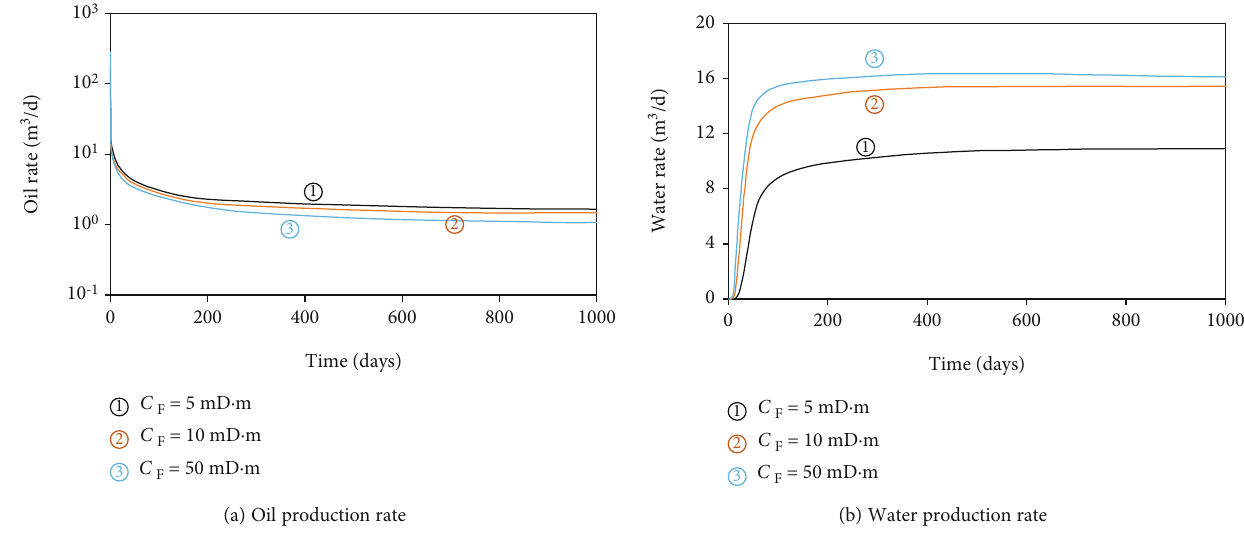
Figure 7: E ff ect of fracture conductivity on oil and water production